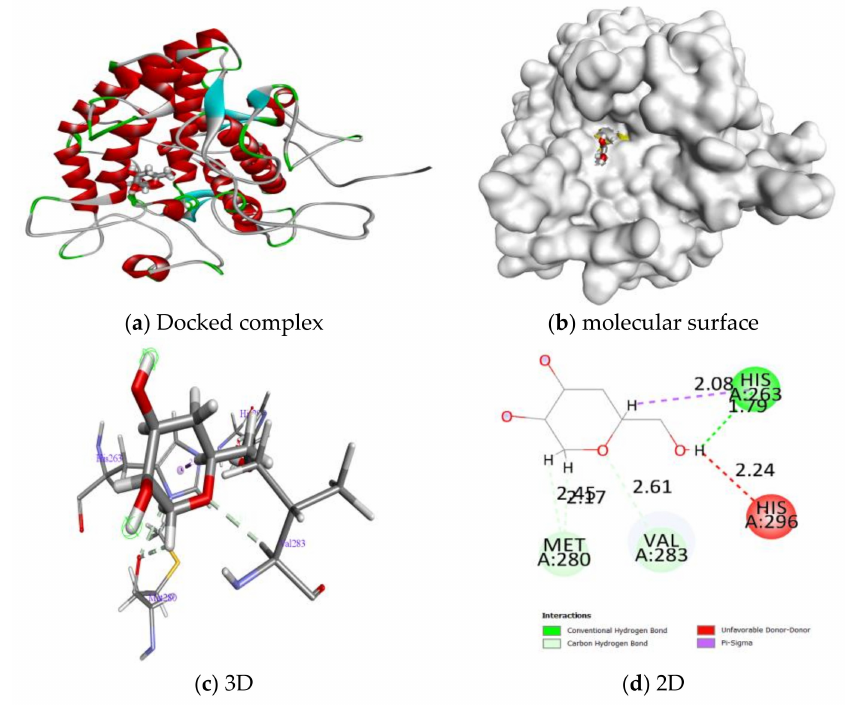
Figure 8. Molecular docking of kojic acid binding site of 2Y9X